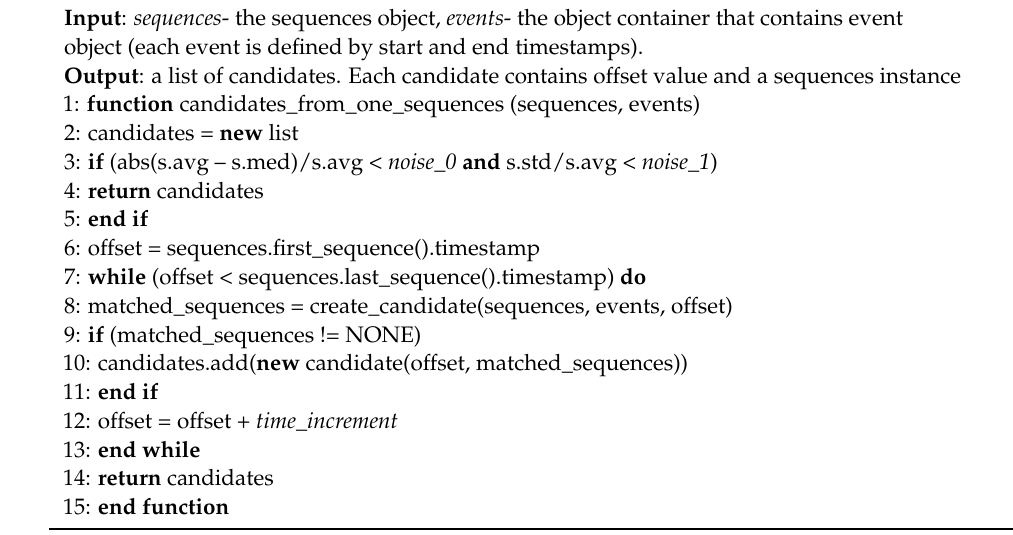
Algorithm 6: Creates a candidate for matching with TS object with a given offset value, basing on the timestamp ranges of the sequences.